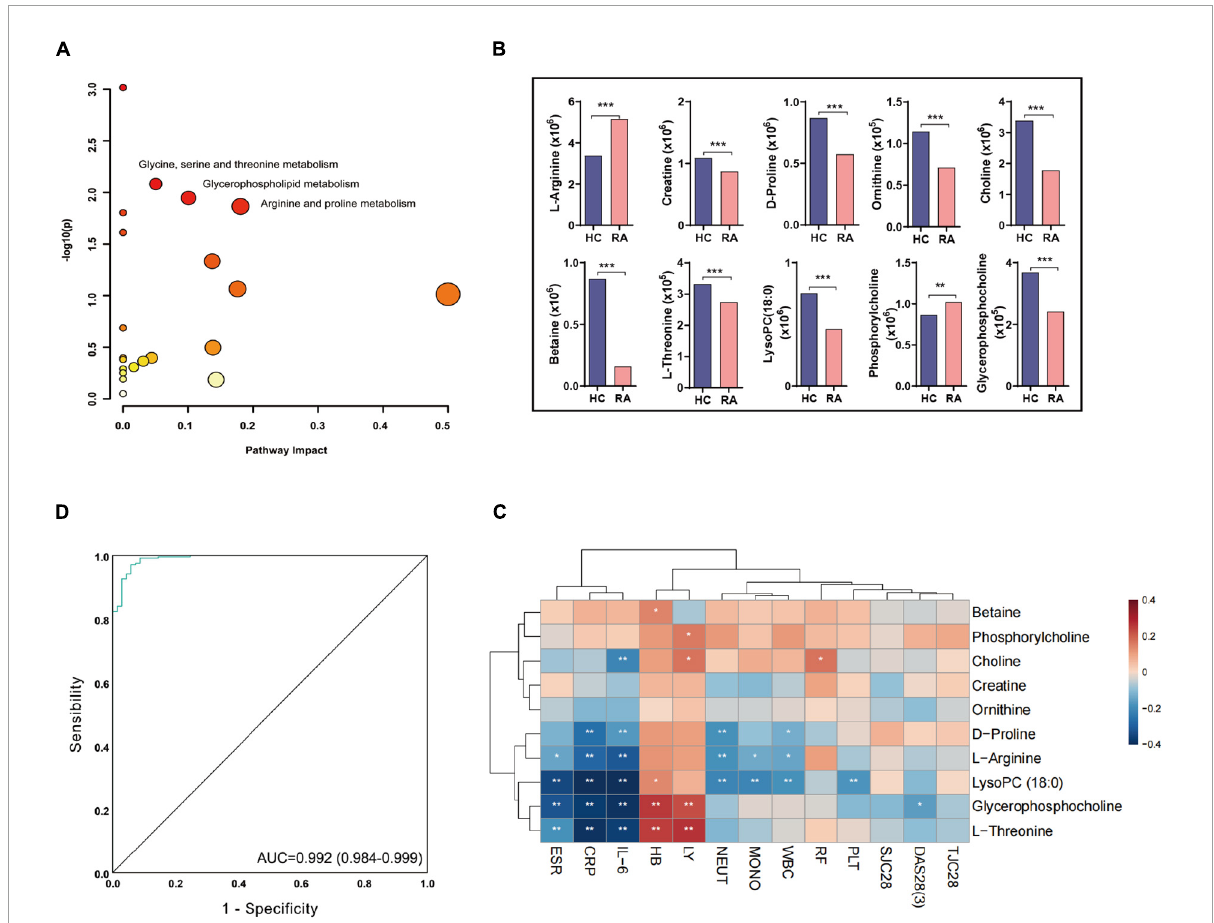
FIGURE2 The biomarkers and pathway in RA based on plasma metabolomics. (A) The three significant pathways are based on 10 differential metabolites between RA and HCs (Pathway impact < 0.2, − log10( p ) value > 1.5 and greater metabolic abundance). (B) The metabolite content differences between RA and HC. * P < 0.05, ** P < 0.01, *** P ≤ 0.001. (C) The correlation heatmap between metabolites and clinical information. (D) The ROC curve of the combination of 10 differential metabolites for classifying RA patients from HC. RA, rheumatoid arthritis; HC, healthy control; DAS28, disease activity score-28; TJC28, tender joint count 28; SJC28, joint swelling count 28; ESR, erythrocyte sedimentation rate; CRP, C-reactive protein; RF, rheumatoid factor; WBC, white blood cell count; LY, lymphocyte count; NEUT, neutrophil count; MONO, monocyte count; HB, hemoglobin; PLT, platelet count, ROC, receiver operating